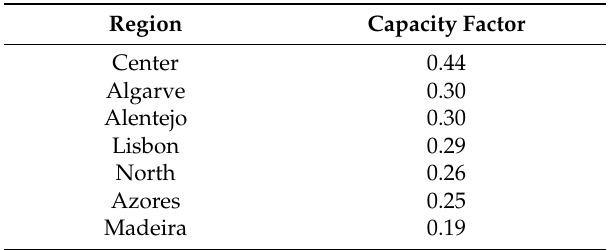
Table 8. Annual wind power capacity factor obtained in different regions of Portugal in 2015 (calculations based on data taken from [3]).